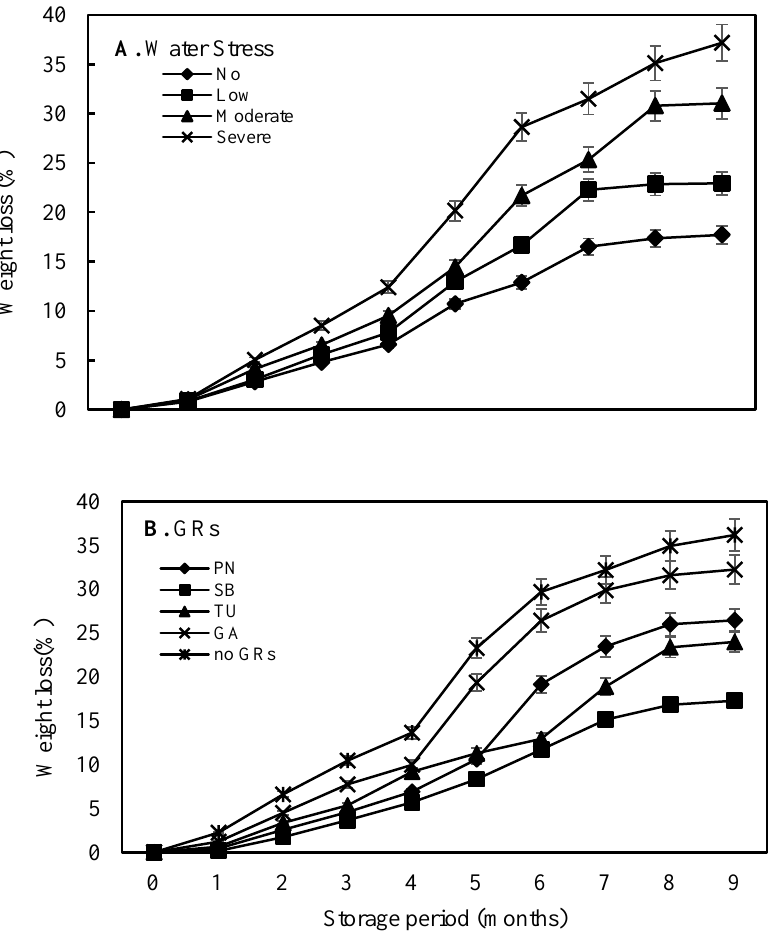
Figure 3. Effect of water stress on the weight loss of onion bulbs ( A ) and growth regulators (GRs) ( B ) across nine months of storage.